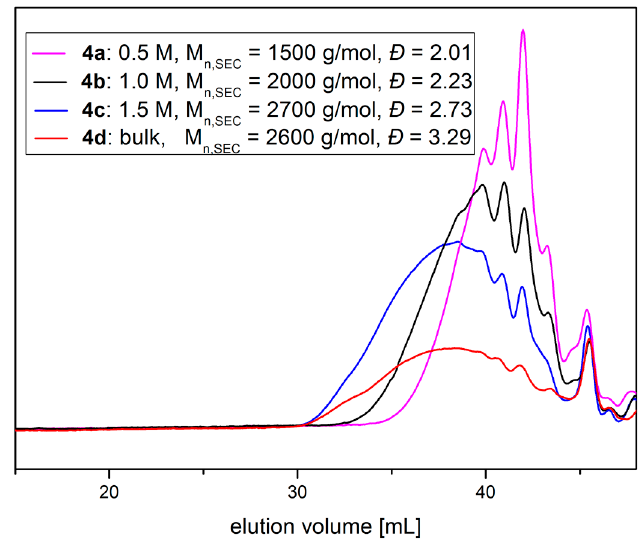
Figure 2. DMF-SEC traces of the reaction of thiolactone-lactone coupler 1 with PEG-diamine and methyl acrylate at c = 0.5 M ( 4a , magenta), 1.0 M ( 4b , black), 1.5 M ( 4c , blue) and in bulk ( 4d , red).